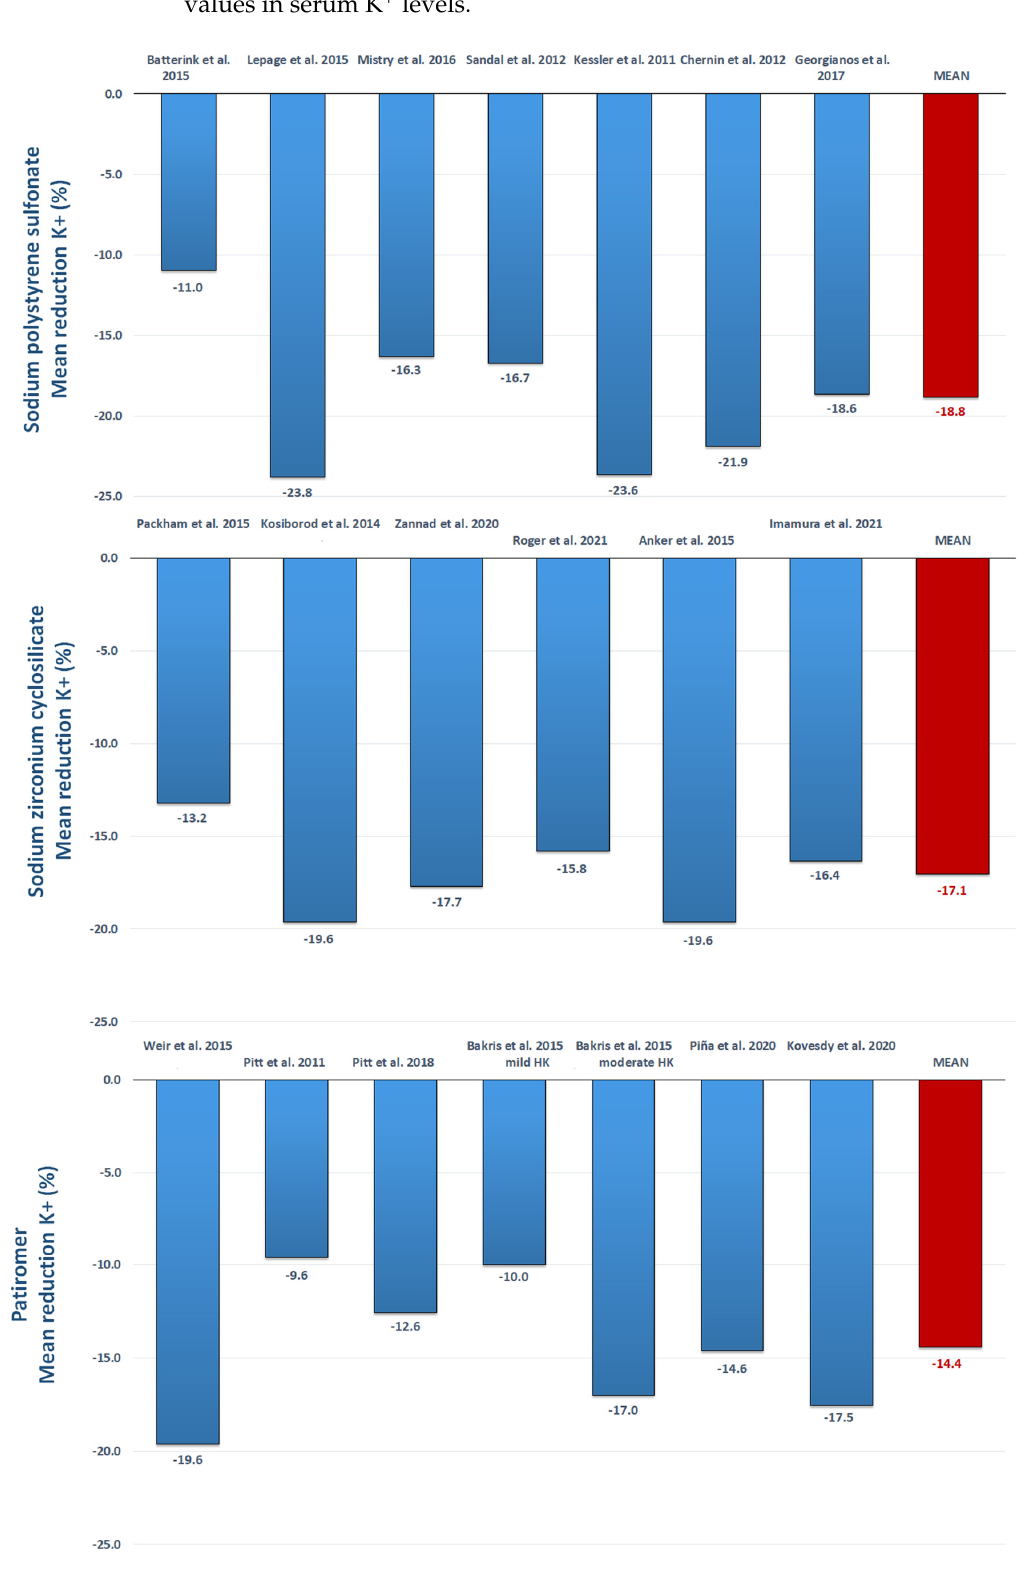
Figure 1. Schematic representation of mean percentage reduction in serum concentration of potassium with the three potassium binders (sodium polystyrene sulfonate, sodium zirconium cyclosilicate, and patiromersorbitex calcium): A reappraisal from literature [33–39,42–44,46,48,49,55–58,60,63].